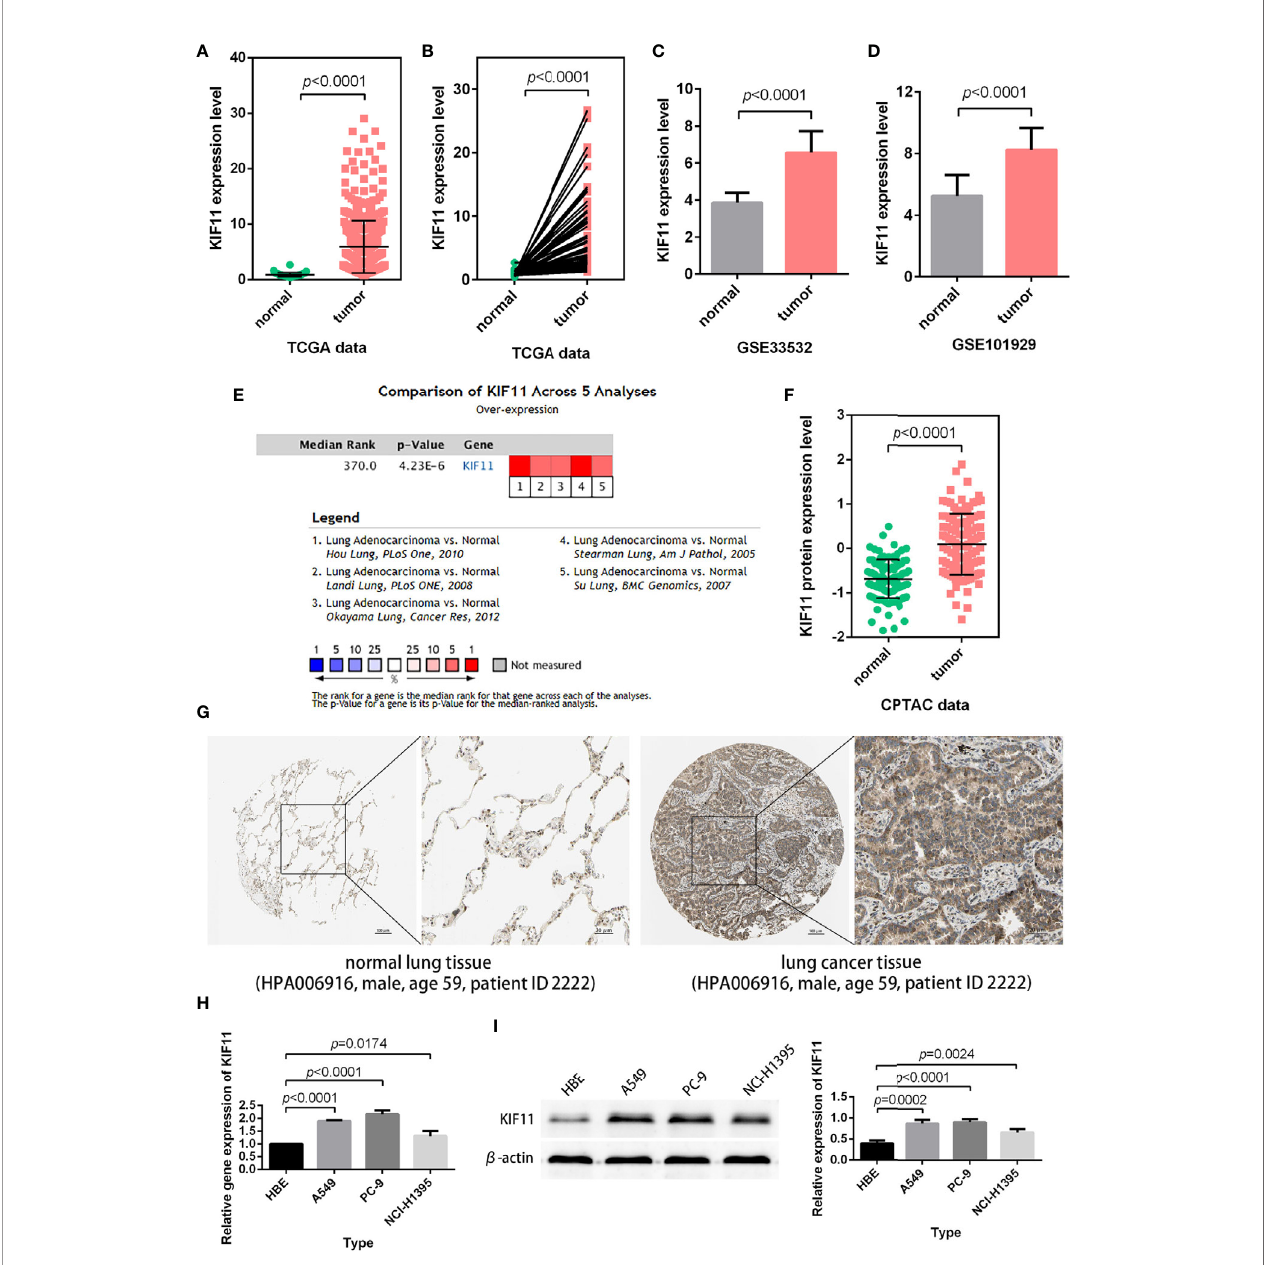
FIGURE 4 | Veri fi cation of KIF11 expression. (A) Unpaired and (B) paired difference analysis of KIF11 expression in the TCGA dataset. KIF11 expression in the (C) GSE33532 and (D) GSE10902 pro fi les. KIF11 expression was upregulated among LUAD samples in (E) a meta-analysis, (F) a protein difference analysis, and (G) immunohistochemical images. KIF11 is highly expressed in A549, PC-9, and NCI-H1395 cells relative to HBE cells as measured by (H) quantitative real- time PCR and (I) western blot